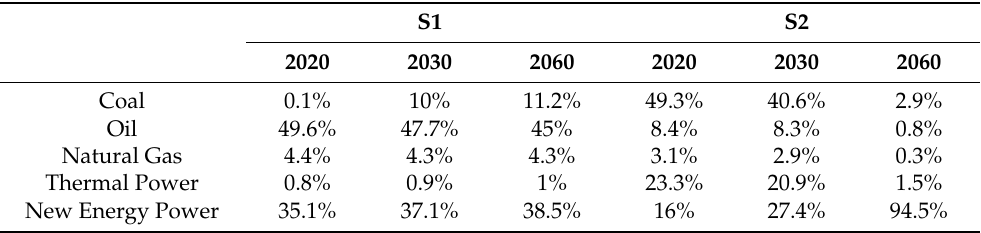
Table 3. The proportion of energy consumption under the S1 scenario & S2 scenario.